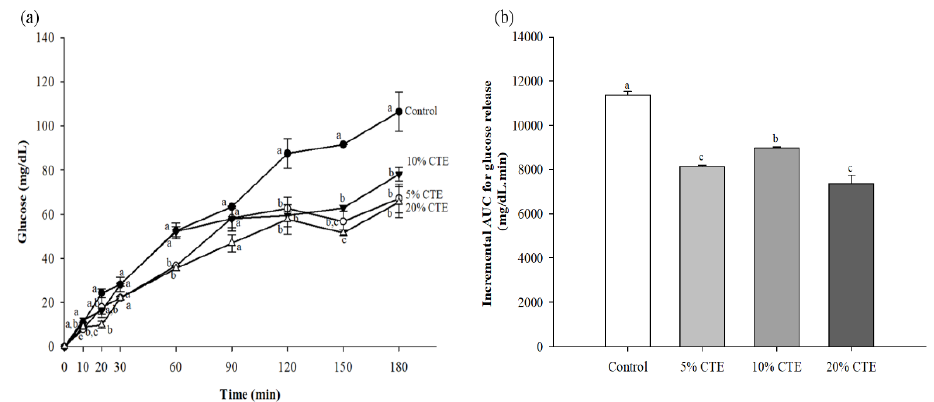
Figure 5. The amount of glucose released from wheat bread after in vitro digestibility ( a ) and incremental area under the curve (iAUC) for glucose release ( b ) when in combination with the different concentrations of CTE. The values of 5%, 10%, and 20% (w/w) represent the concentration of CTE, respectively. The results are expressed as mean ± standard error of the mean (SEM), n = 4. The different letters denote statistically significant differences in mean values. ( p < 0.05) Mean values with the same superscript letters (a, b or c) were similar and no statistically significant differences were observed for these samples.